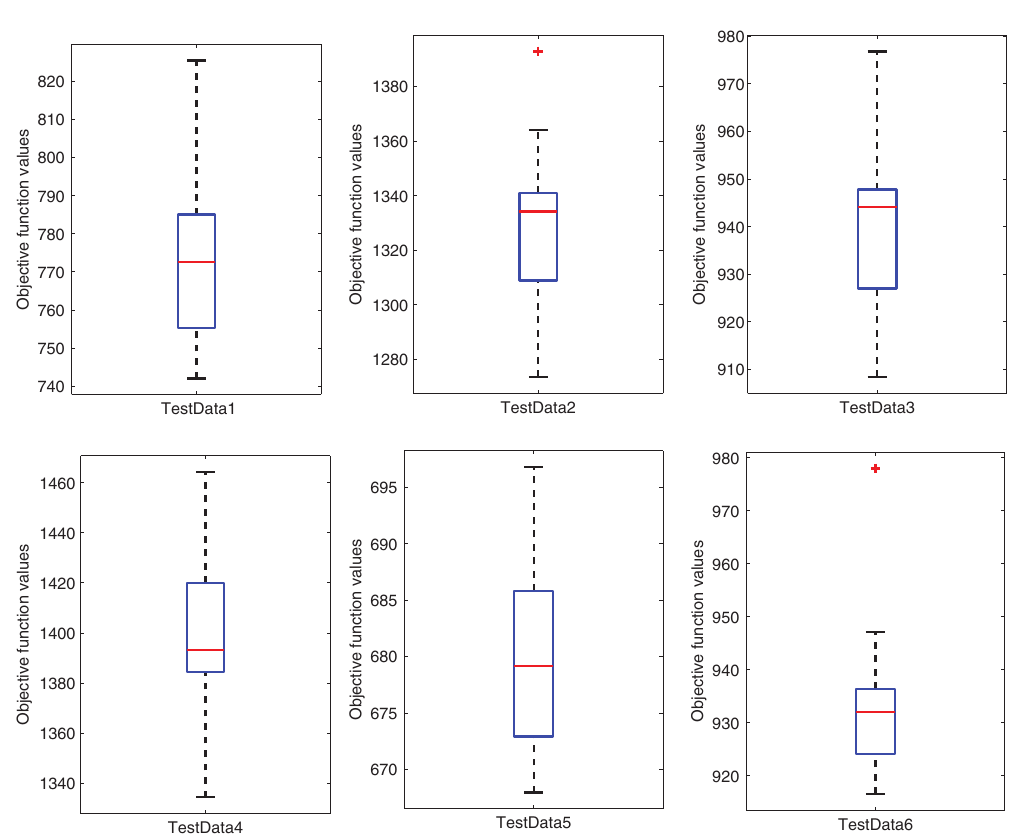
Figure 1: All the Instances Summarized Using Box and Whisker Charts.